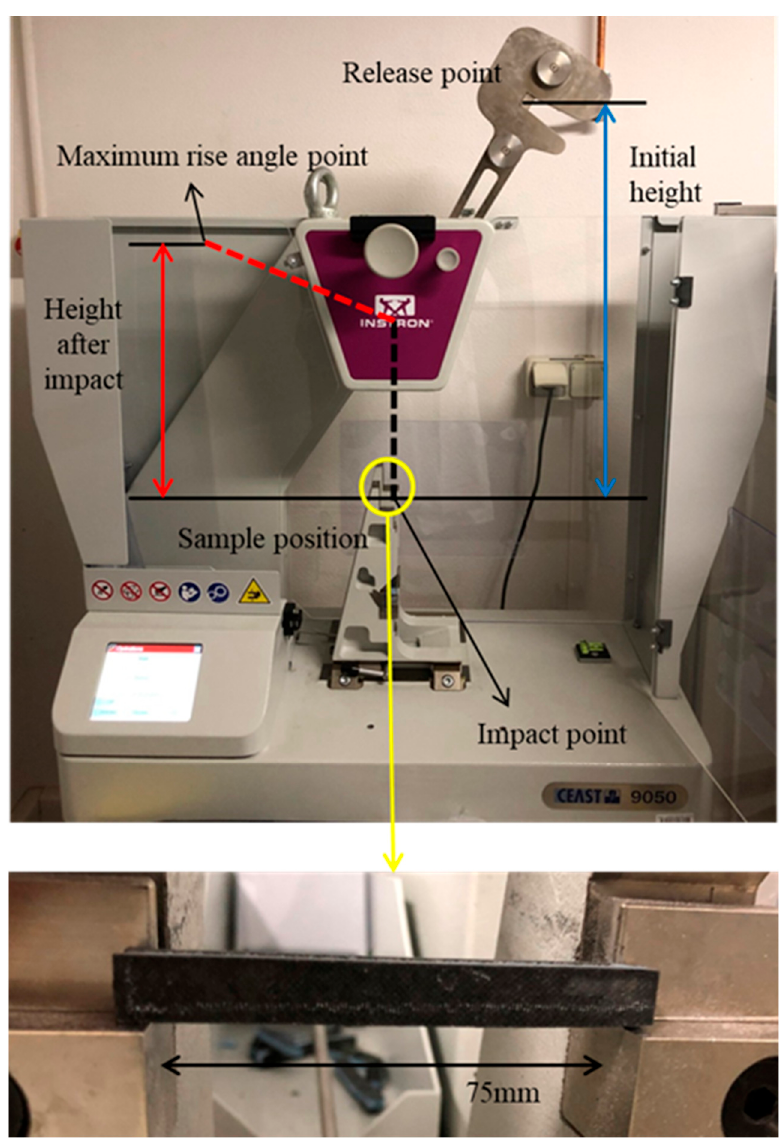
Figure 4. Charpy impact test schematization.